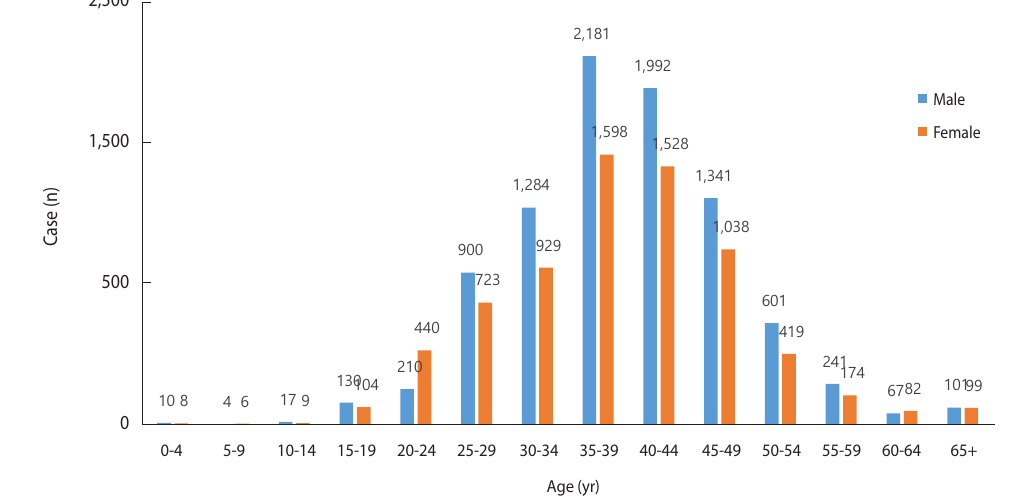
Figure 3. Age distribution of reported hepatitis A cases in Korea, 2019 (as of October 13, 2019).